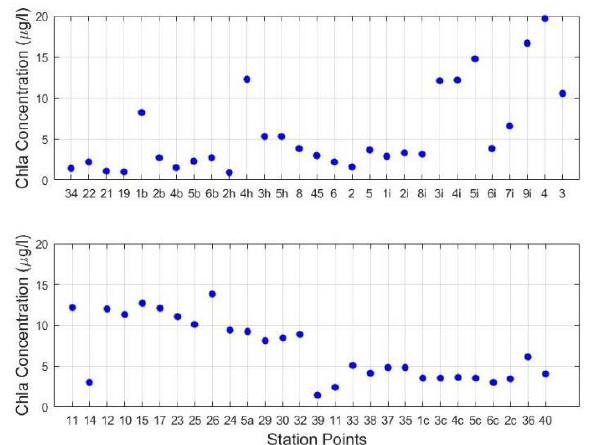
Figure 2. In situ chlorophyll-a data (July, 2018) were